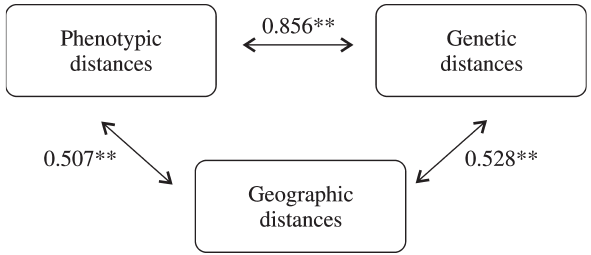
Figure 3 - Schematic representation of the structure of linear correlation among the matrixes of geographic, phenotypic and genotypic